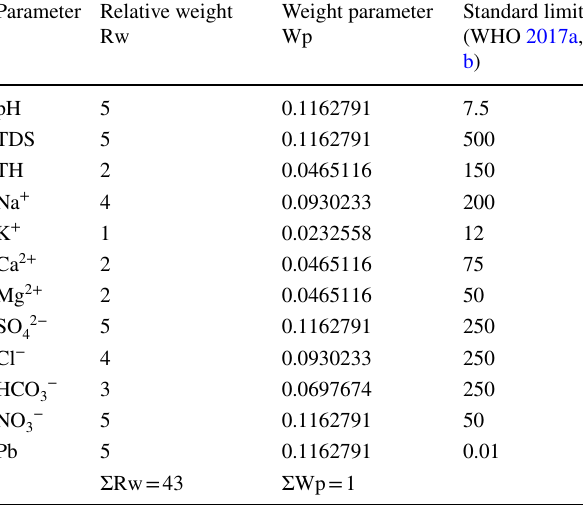
Table 2 PIS components required for evaluation Parameter Relative weight